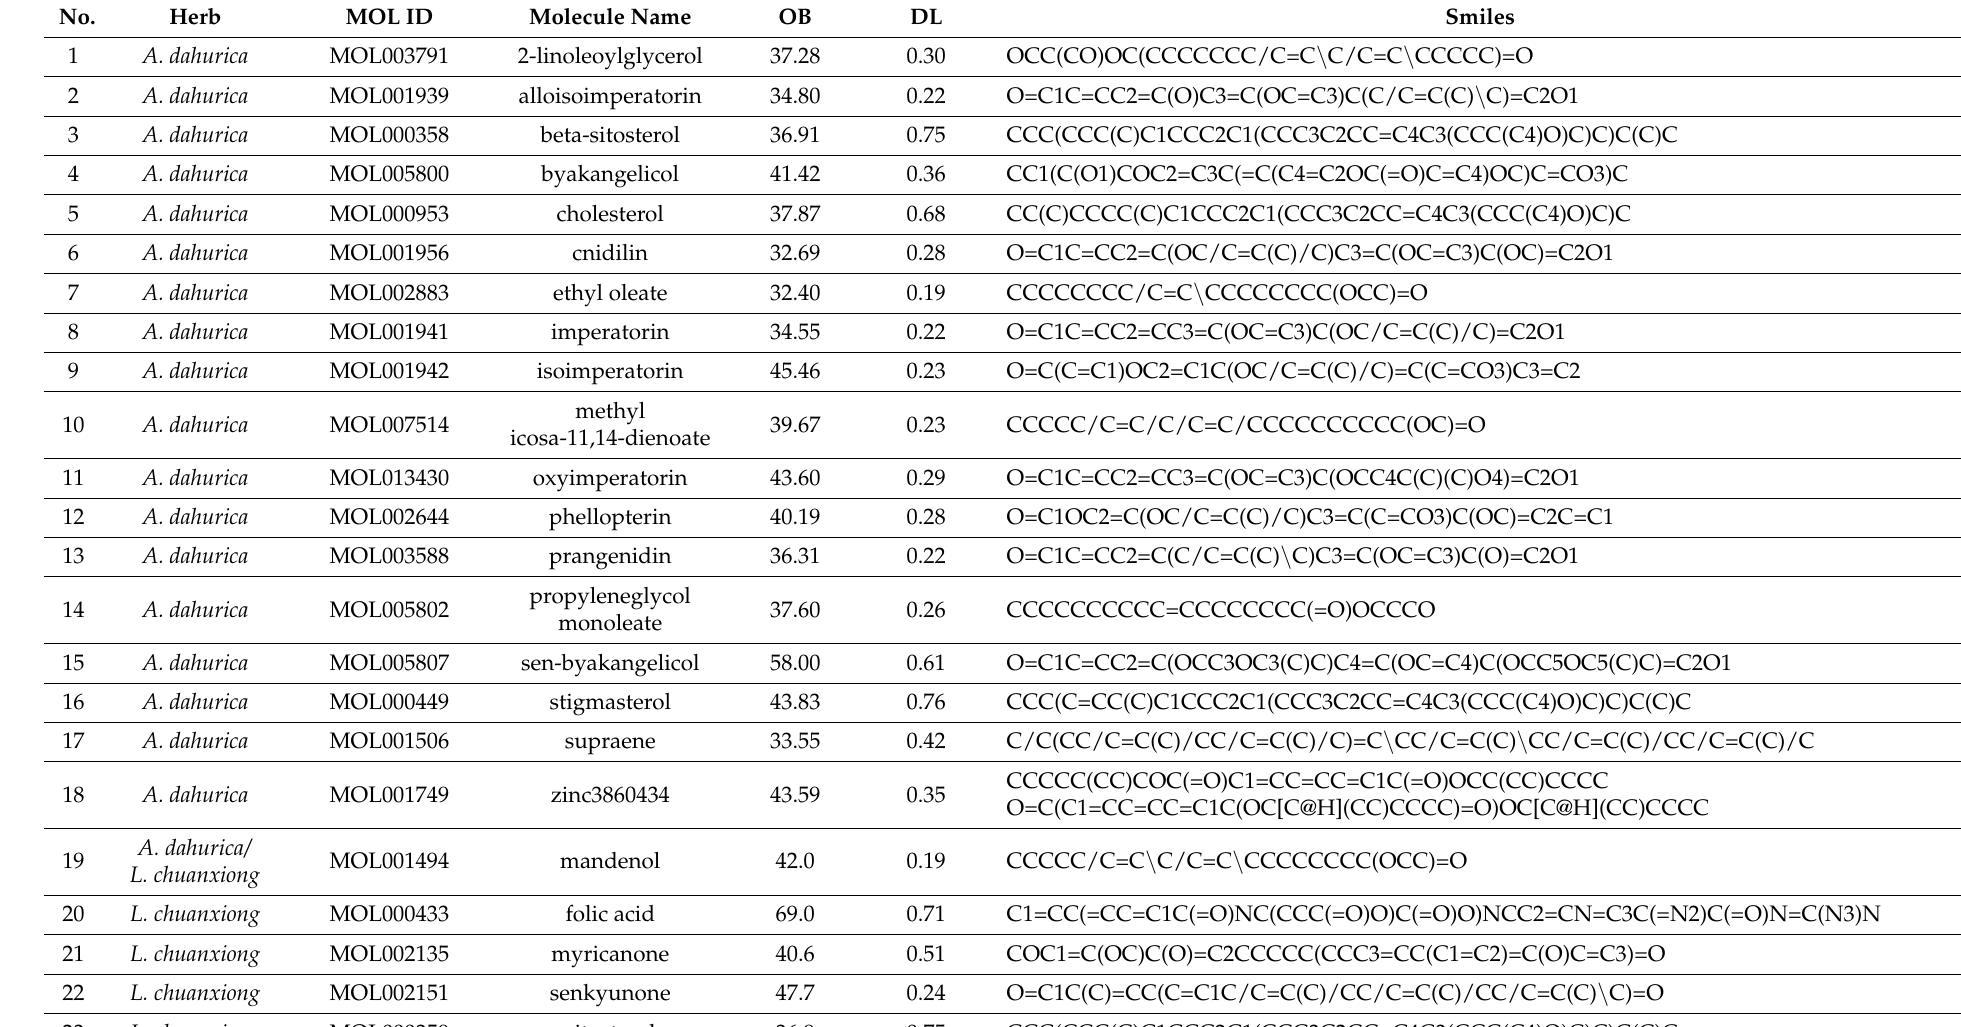
Table 1. The selected active compounds of